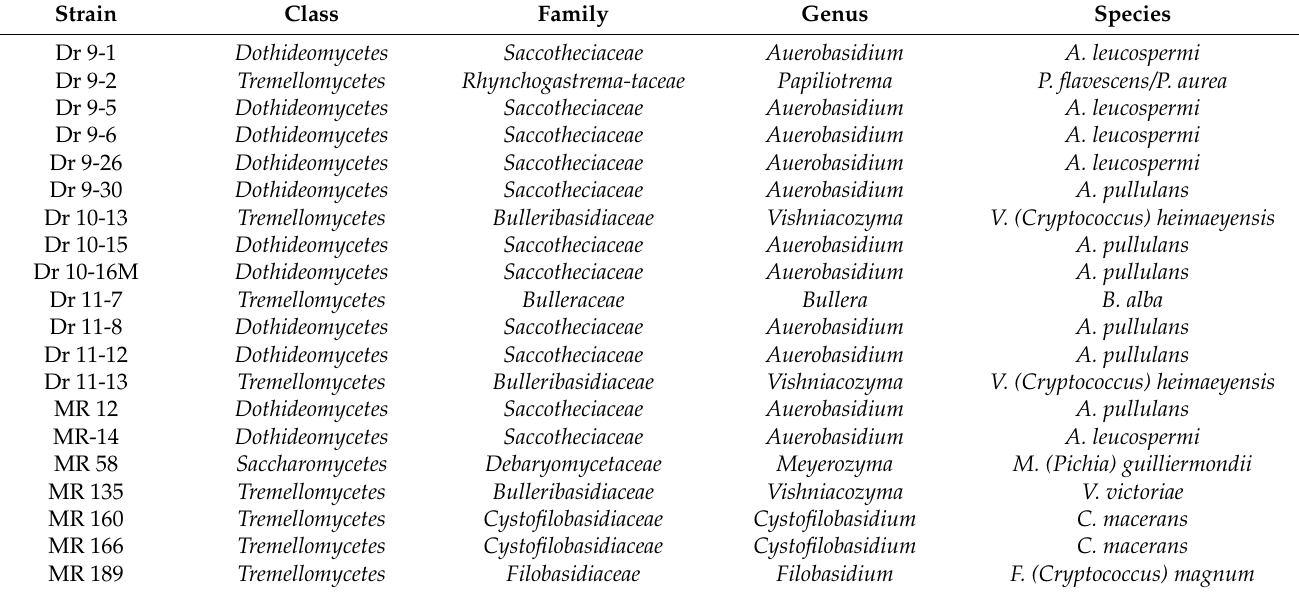
Table 4. Taxonomic positions of isolated fungal isolates determined by molecular genetic